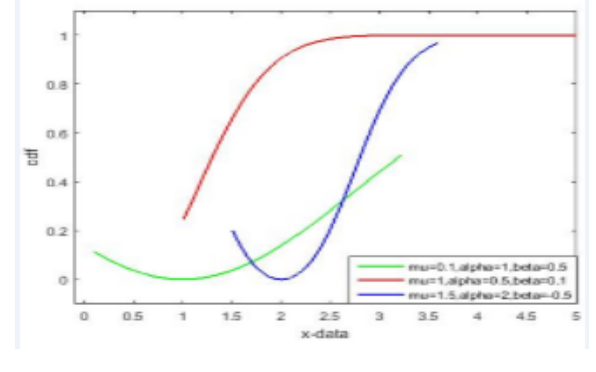
Fig. 1. Plot the cdf distribution.